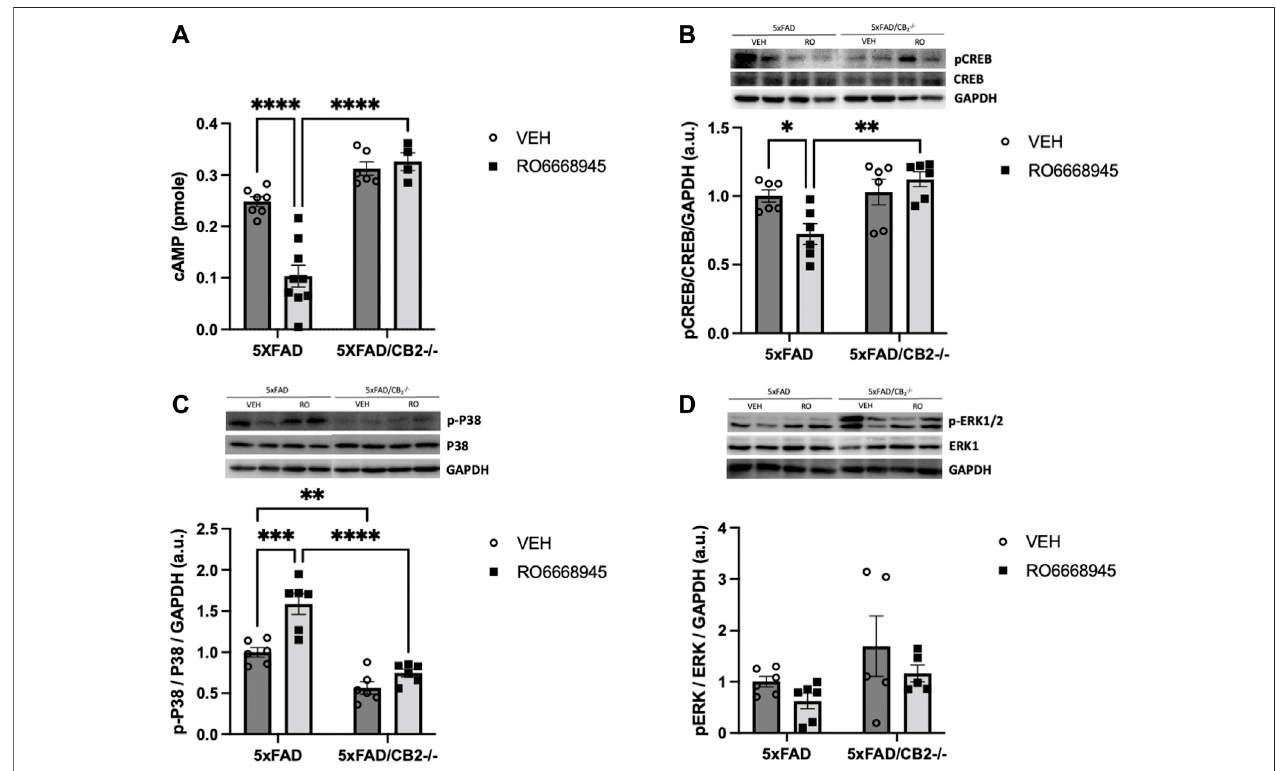
FIGURE 4 | Signaling cascades regulated by the activation and deletion of cannabinoid CB 2 receptors. (A) cAMP and p-CREB (B) levels were signi fi cantly decreasedbythetreatmentwiththeCB 2 agonist,remainingunalteredinsamplesfromCB 2 -nullmice. (C) p-p38MAPKlevelsweresigni fi cantlyelevatedbytheexposure totheagonist;inaddition,samplesfrom5xFAD/CB 2-/- miceexhibitedsigni fi cantlylowerlevels. (D) p-ERKlevelswerenotmodi fi edbythetreatmentwiththeCB 2 agonist orthegeneticdeletionofthereceptor.Two-wayANOVAfollowedbyTukey ’ spost-hoctest.* < p 0.05;** < p 0.01;*** < p 0.001;**** < p 0.0001.N=4 – 9micepergroup. Data represent mean ±